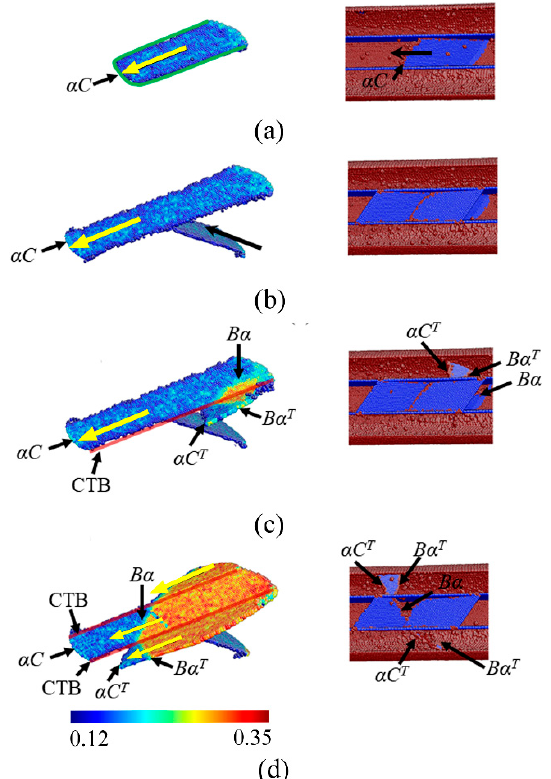
Figure 7. Snapshot of the NT Au nanowire with θ = 90° and λ = 5.45 nm during stretching at stain of ( a ) 2.95%, ( b ) 3.13%, ( c ) 3.38%, and ( d ) 3.43%. On the left panel, the atoms are colored according to the slip vector analysis (SVA), where the atoms with SVA less than 0.12 nm are hid. On the right panel, the atoms are colored according to the CNA, where the atoms with FCC lattice are hid. The green curve illustrates the dislocation line and the red lines mark the CTBs. The yellow arrows denote the direction of dislocation slip.